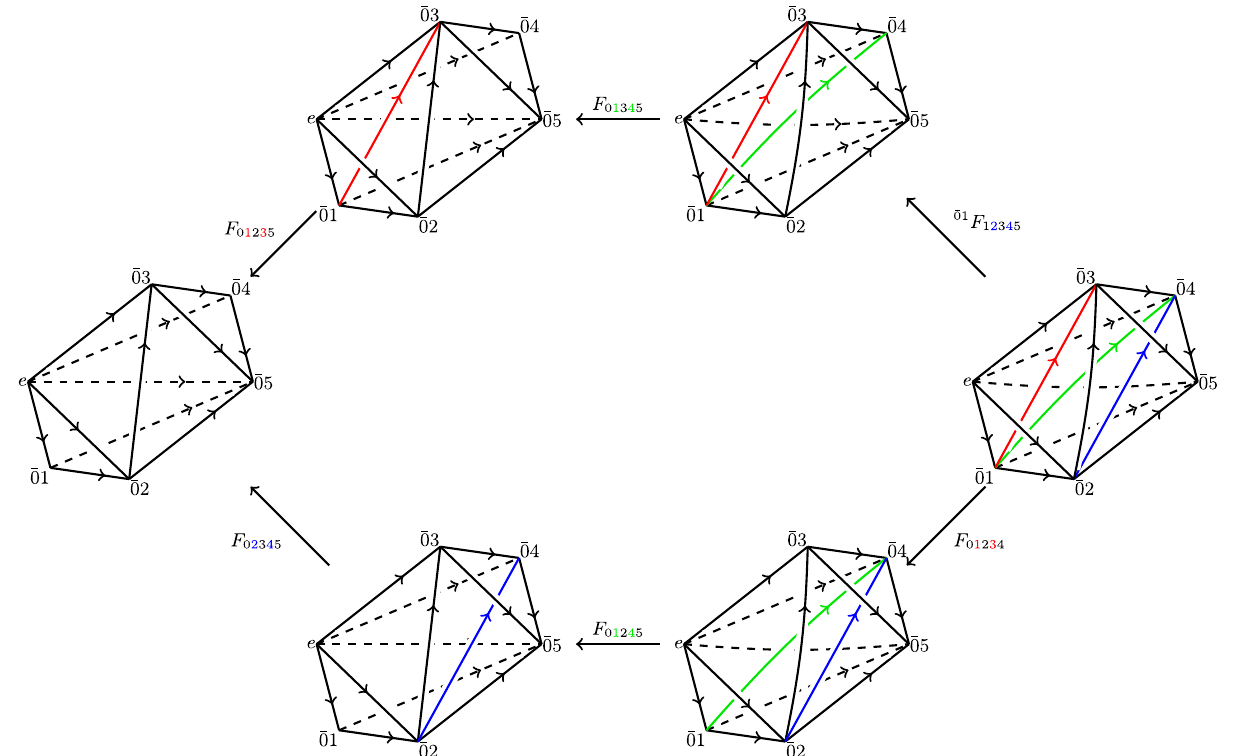
FIG. 11. Standard superfusion hexagon equation. Algebraically, this standard superhexagon condition corresponds to Eq. (213). The colored numbers i and j in the subscript of F indicate that the link h ij i with the same color is added after this F move. Since the group , all the fermionic F moves are standard except element label of the first vertex is e ∈ G b ¯ ¯ F ð e; ¯ ij; ¯ jk; kl; lm Þ for the standard F move. We also omit all the fermion layers in the